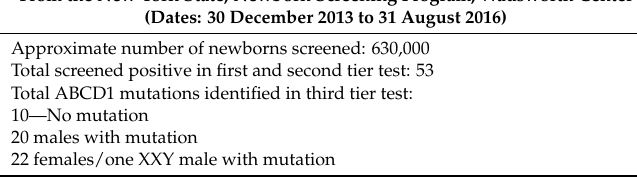
Table 1. Data: newborn screening for X-linked